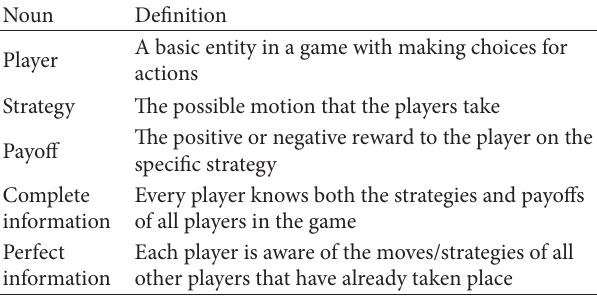
Table 6: The nominal definition of the game theory.